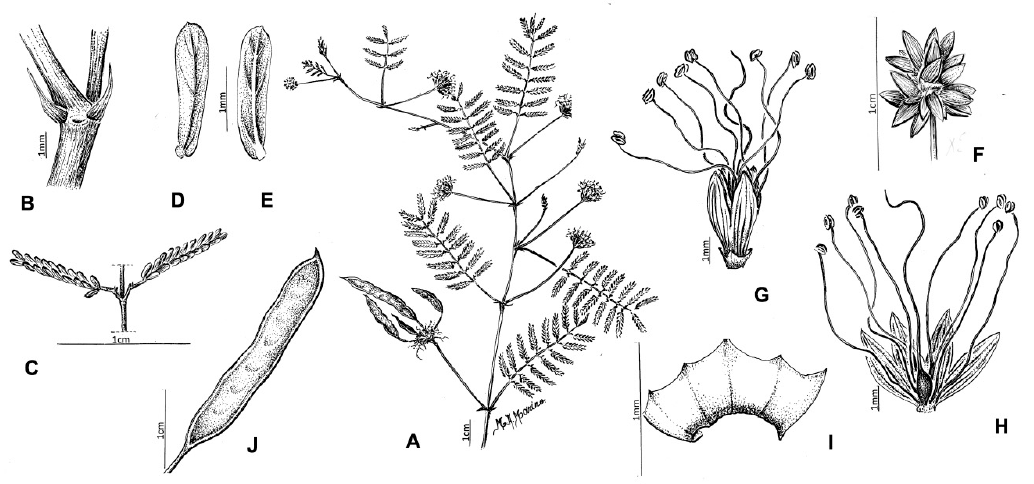
Figure 1. Mimosa carolina. ( A ) Flowering and fruiting branch; ( B ). Stipules. ( C ). Section of the primary rachis with one pair of pinnae. ( D ). Leaflet, adaxial face. ( E ). Leaflet, abaxial face. ( F ). Inflorescence. ( G ). Closed flower. ( H ). Opened flower. ( I ). Opened calyx. ( J ). Fruit. Drawn from the isotype (BAB) by Angélica Marino.